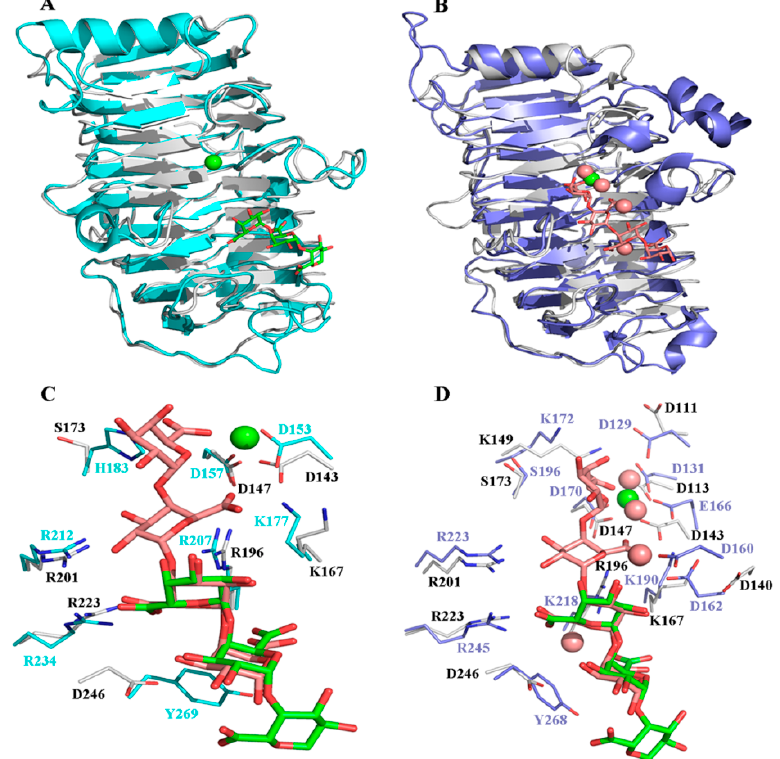
Figure 2. Structural comparison of BacPelA with BspPelA-TGA-Ca 2+ and EcPelC-tetragalacturonate- Ca 2+ . ( A ) The BacPelA (gray) is superimposed with BspPelA-TGA-Ca 2+ (blue; PDB ID: 3VMW). ( B ) The BacPelA (gray) is superimposed with EcPelC-tetragalacturonate-Ca 2+ (purple; PDB ID: 2EWE). ( C ) Detailed interaction comparison in the substrate and Ca 2+ binding clefts of BacPelA and BspPelA. ( D ) Detailed interaction comparison in the substrate and Ca 2+ binding clefts of BacPelA and EcPelC. TGA and tetragalacturonate (TetraGal p A) are shown in green and brown, respectively. The only Ca 2+ ion and the four Ca 2+ ions are shown as green sphere and brown spheres, respectively.